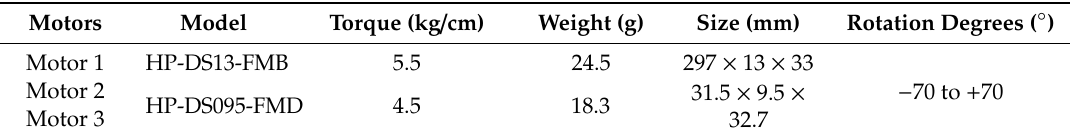
Table A1. Parameters of metacarpal.